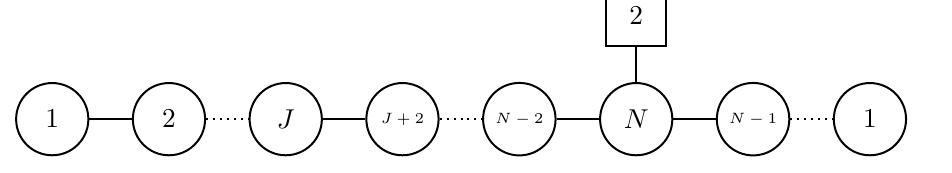
Figure 22 . The mirror of U( N − k ) N f = 2 N − 2 k SQCD plus a decoupled SU( N ) × SU( k )